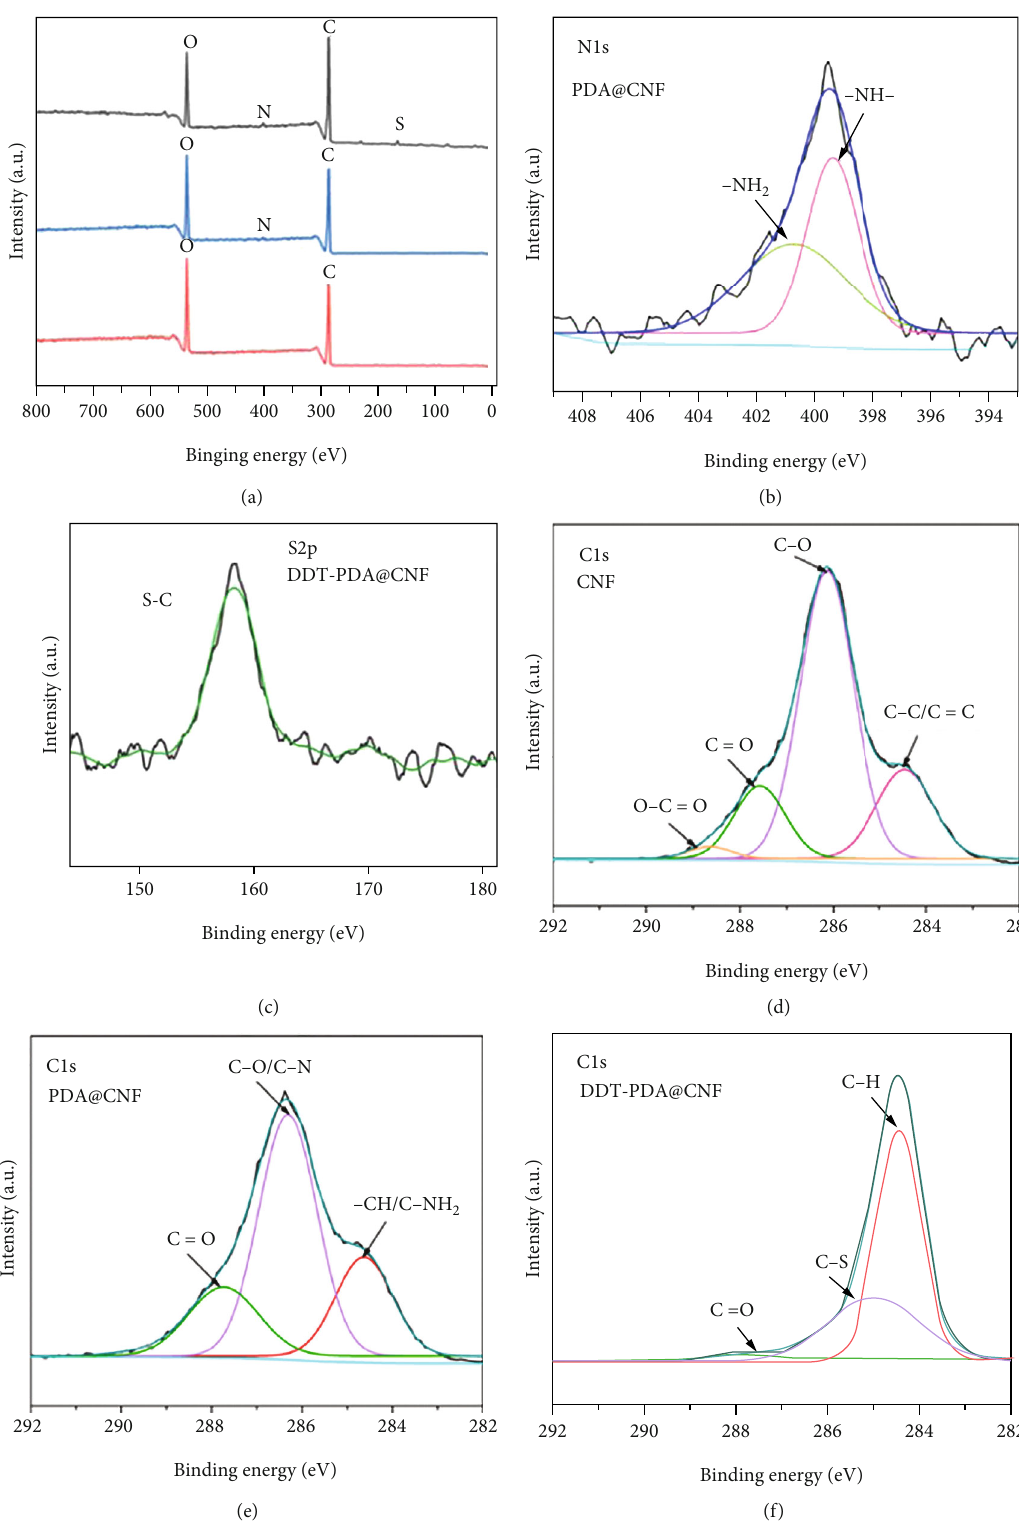
Figure 4: (a) Down to top: XPS survey spectrum of CNF, PDA@CNF, and DDT-PDA@CNF, (b) high resolution N 1 s spectrum of PDA@CNF, (c) high resolution S 2p spectrum of DDT-0.5PDA@CNF, and (d) – (f) high resolution C 1 s spectrum of CNF, 0.5PDA@CNF, and